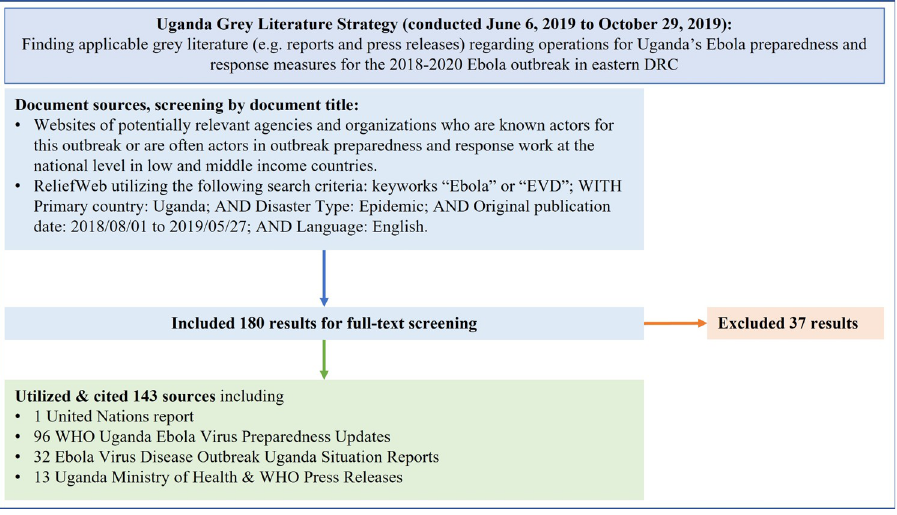
Fig 1. Grey literature search